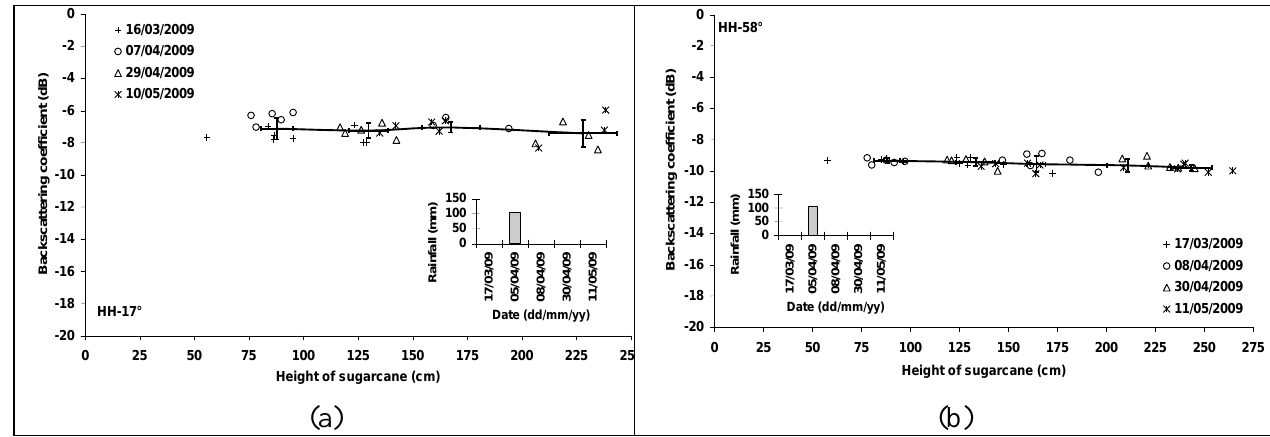
Figure 4. Radar backscattering coefficient as a function of plant height for HH polarization and incidence angles of 17° and 58°. The sugarcane height corresponds to the height of terminal visible dewlap (htvd). Bars represent standard deviation of the mean.